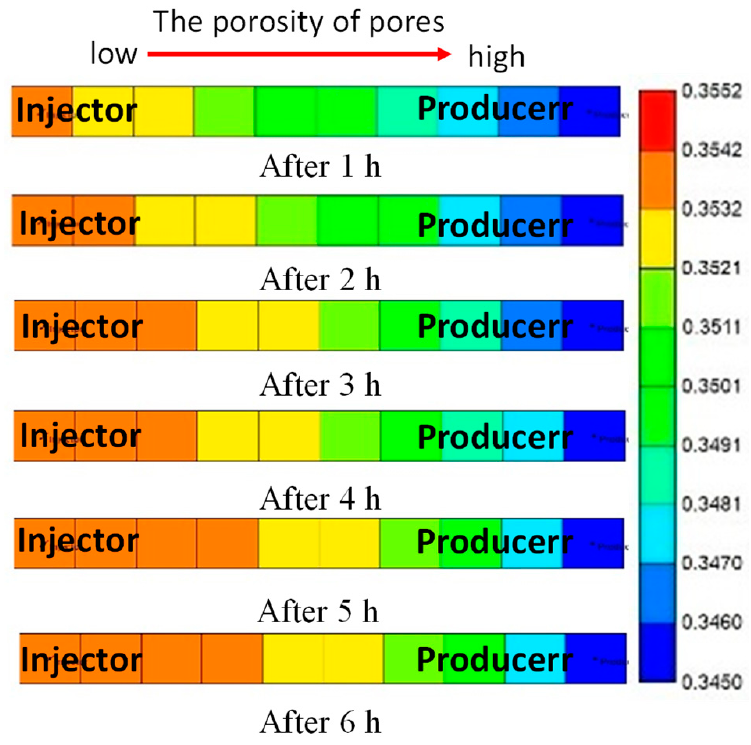
Figure 9. Simulation results of particle migration.